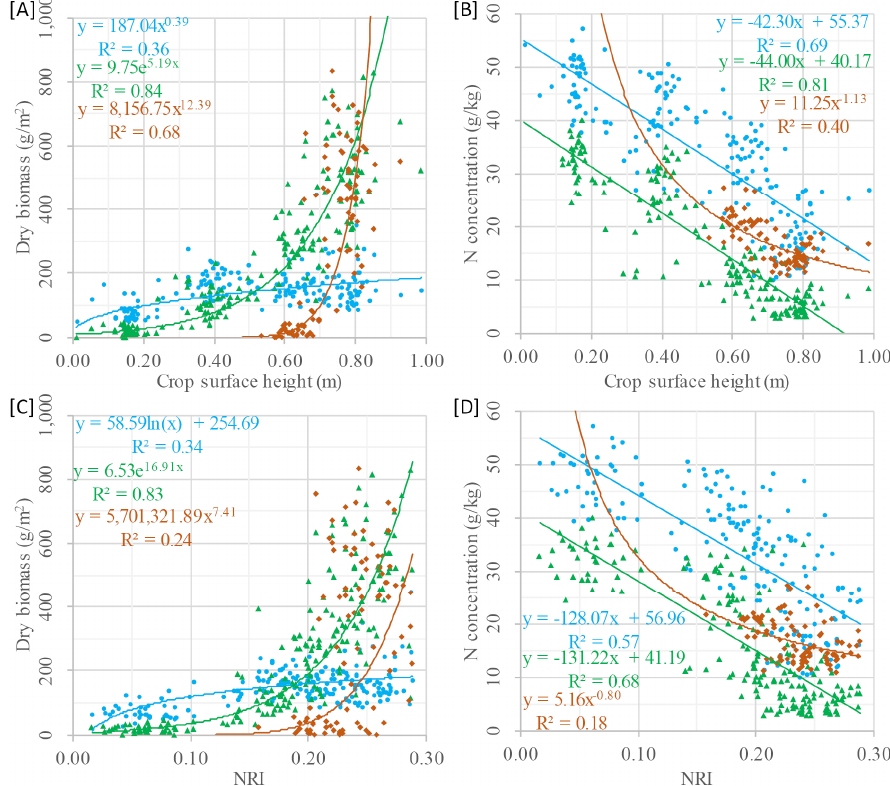
Figure 5. Scatterplots of dry biomass and N concentration per plant vs. crop surface height ([ A ] and [ B ]) or NRI ([ C ] and [ D ]) with best-fitting regression lines. Blue dots, green triangles, and orange rhombs represent the values of leaf, stem, and ear, respectively.